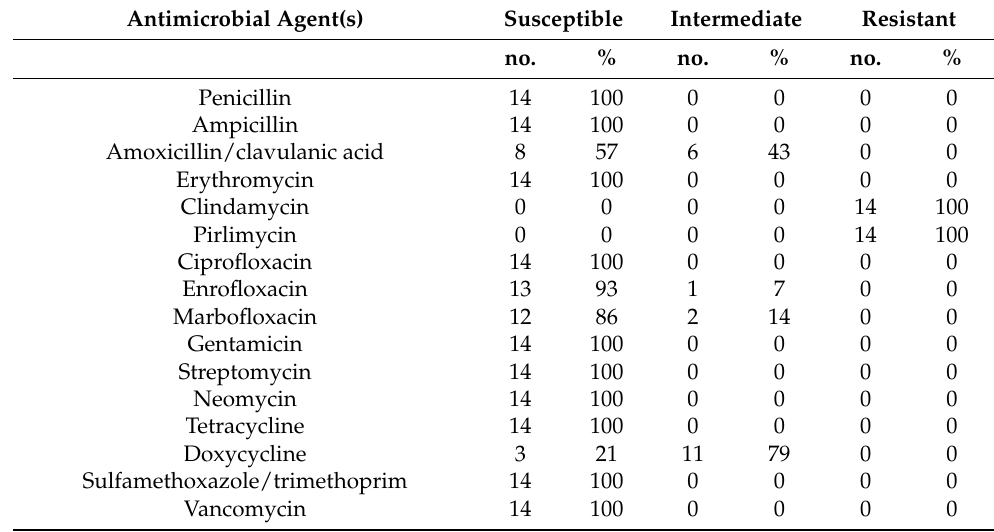
Table 4. Susceptibility testing results of the 14 L. monocytogenes isolates for antimicrobial agents with existing clinical